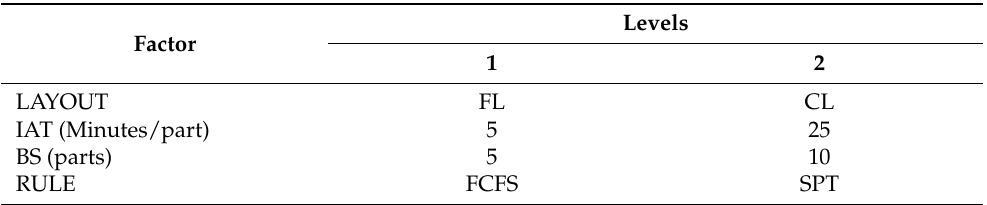
Table 3. Studied factors and levels for the FMS case study.